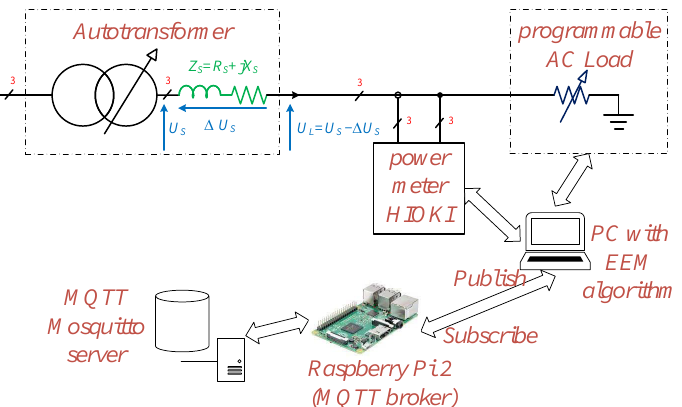
Figure 15. Schematic diagram of experimental